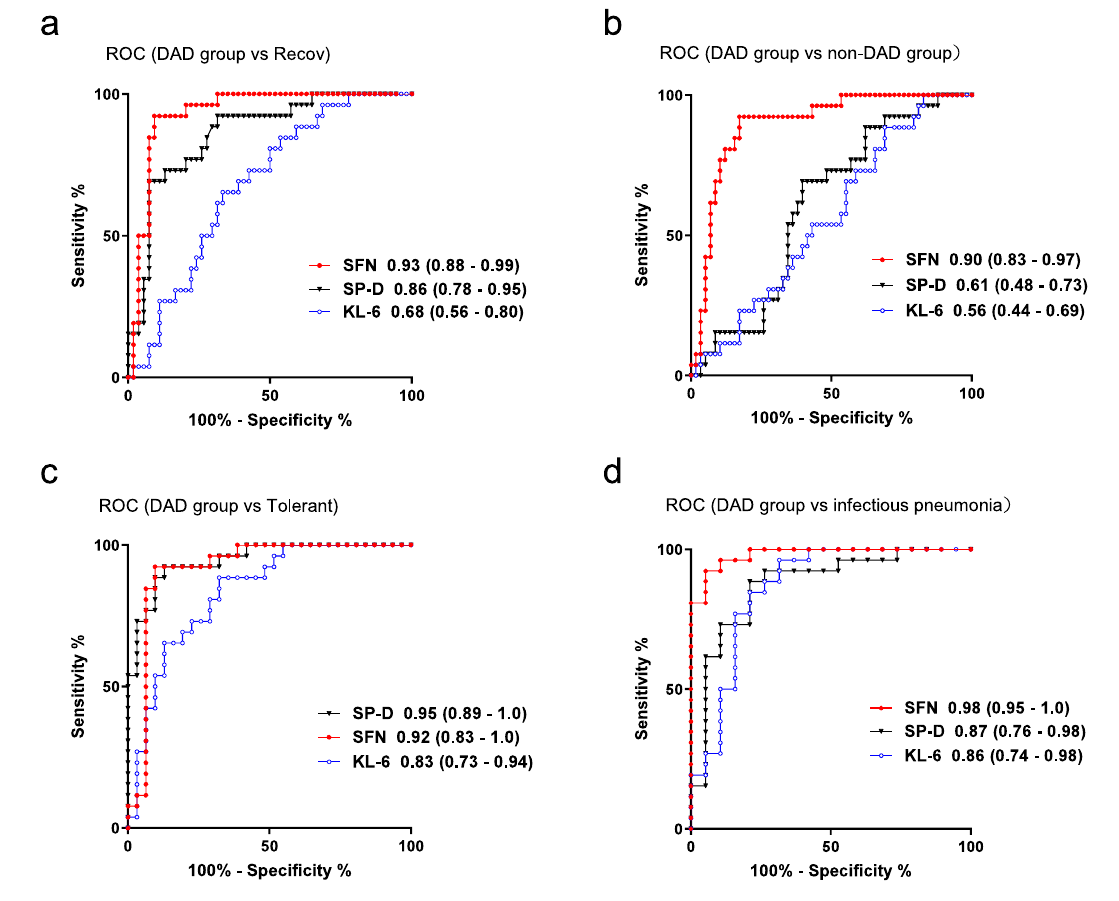
Fig.3|ROCcurvesforSFNandknownbiomarkers. DataoftheCombinedcohort areshown.ROCcurvesforSFNaswellastheexistingmarkers(SP-DandKL-6)were drawn to discriminate the acute phase of DAD patients from a all patients in recovery (discrimination of the disease activity), b acute-phase patients with other